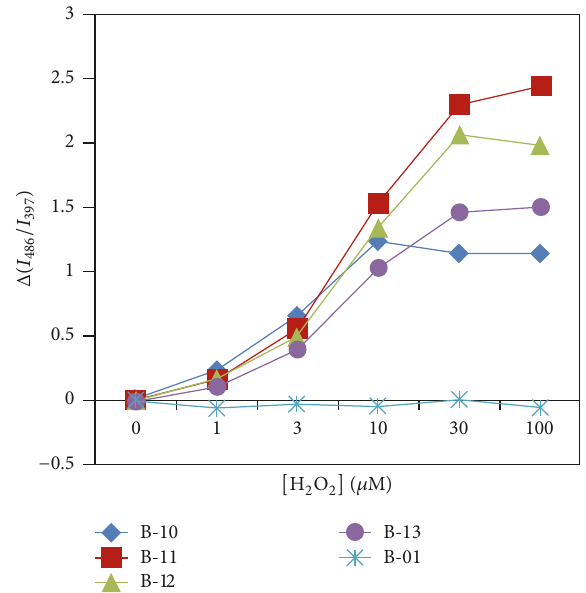
Figure 4: Ratio of excimer (486 nm) to monomer (397 nm) emis- sion intensities for aqueous solutions of polymer B-11 containing (30 𝜇 M) or not containing H 2 O 2 as a function of pH at 25 ∘